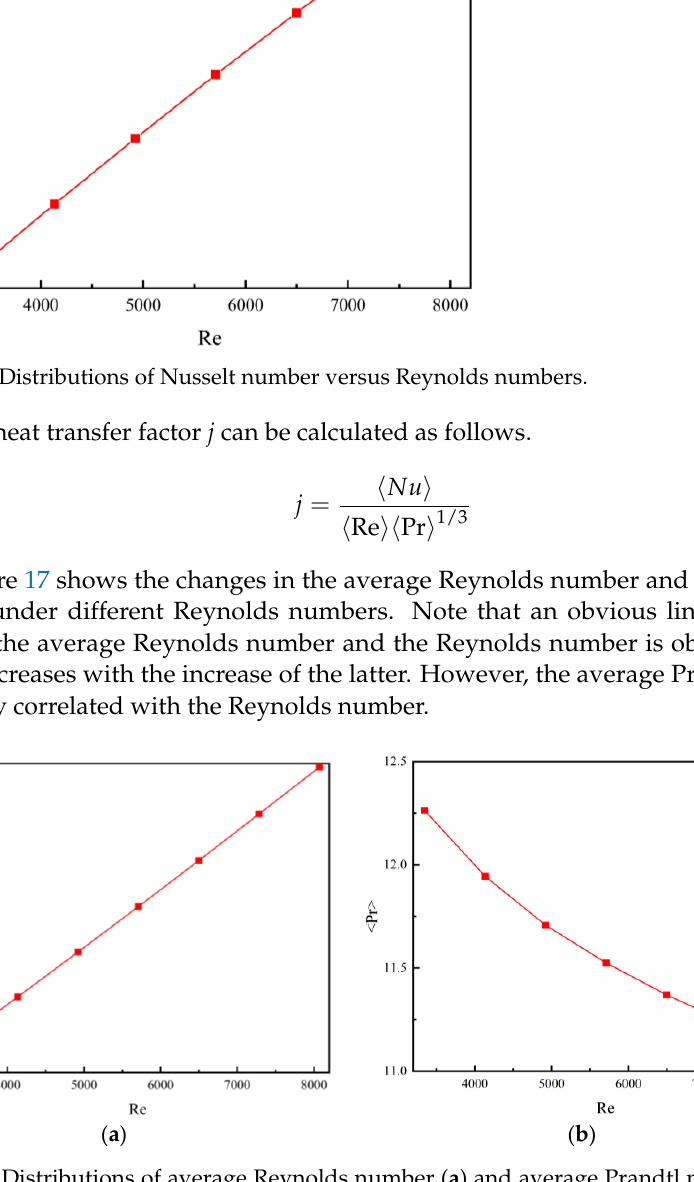
Figure 17. Distributions of average Reynolds number ( a ) and average Prandtl number ( b ) versus Reynolds numbers.